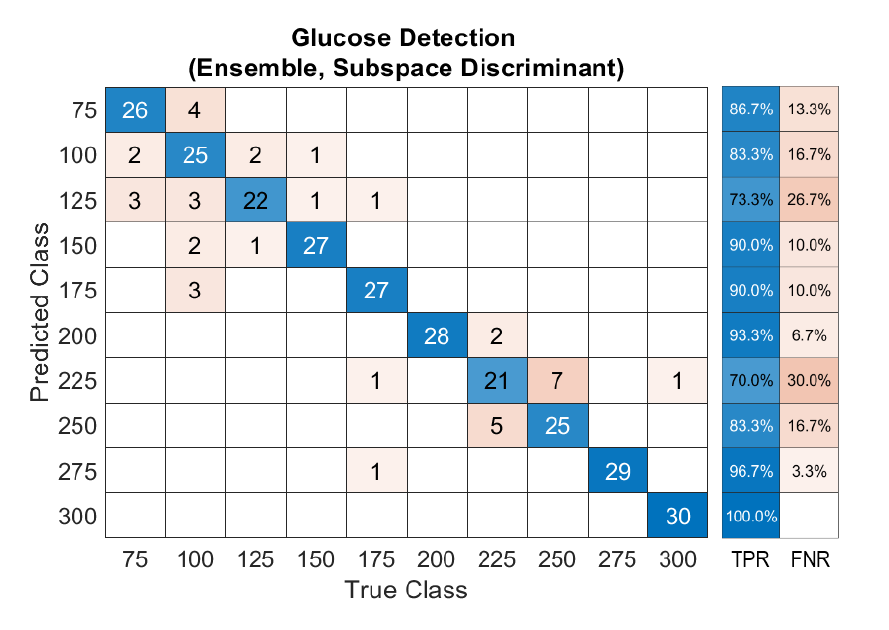
Figure 10. Confusion matrix of the ensemble model for glucose